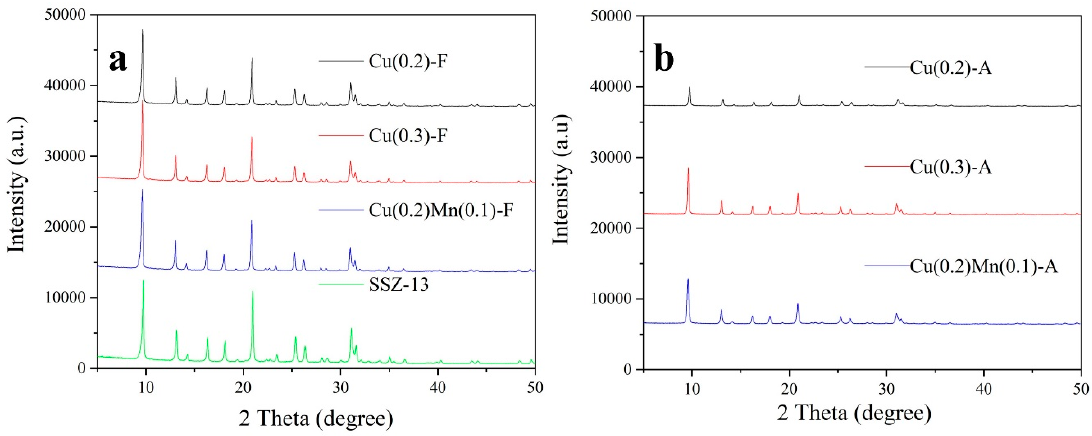
Figure 6. X-ray di ff raction (XRD) patterns of catalysts before ( a ) and after ( b ) hydrothermal Figure 6. X-ray diffraction (XRD) patterns of catalysts before ( a ) and after ( b ) hydrothermal aging.